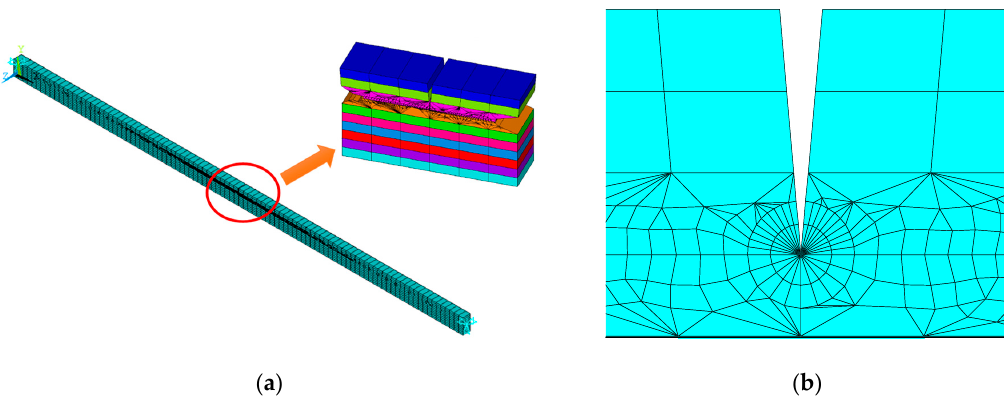
Figure 2. ANSYS models for the cracked functionally graded-graphene nanoplatelets reinforced composite (FG-GPLRC) beam. ( a ) Mesh of beam, ( b ) mesh of crack tip. For the finite element method, the model of the cracked FG-GPLRC beam is discretized into an assemblage of discrete finite elements, which are interconnected at the nodal points on element boundaries. The displacement field can be represented using the nodal displacements, which is approximated over each finite element. The equations of motion can then be formulated using the equations of motion can be written as [47],